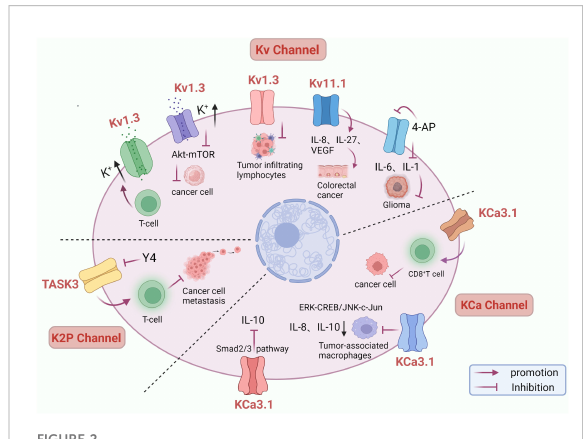
FIGURE 2 Role of potassium channels in immunotherapy. Inhibition of Kv1.3 channels leads to impaired tumor-in fi ltrating lymphocyte function and decreased ability to kill cancer cells. Kv1.3 overexpression decreases intracellular potassium and enhances antitumor function of T cells through activation of Akt – mTOR signaling. 4-AP blocked potassium channels and inhibited IL-6 and IL-1 secretion, inhibiting glioma cell proliferation. Up- regulation of Kv11.1 channel expression was accompanied by increased IL-8, IL-27, and VEGF, promoting colorectal cancer development. KCa3.1 activator suppress IL-10-induced tumor immune surveillance escape and IL-8-induced tumorigenicity and metastasis by inhibiting their production from TAMs through ERK-CREB and JNK-c-Jun cascades. KCa3.1 activator enhanced the killing effect of CD8 + T on tumor cells and induced IL-10 transcriptional inhibition in T lymphocytic leukemia through the Smad2/3 signaling pathway. Y4 mAb increases cell death by targeting inhibition of KCNK9 channels and activating anti-tumor immune